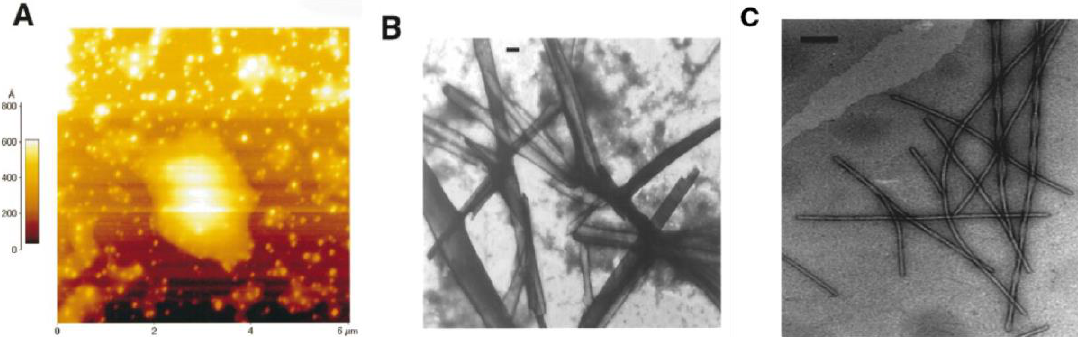
Figure 2. Atomic force (AFM) and electron microscope examination of aggregates of short sequences of hIAPP in its core mutation region. ( A ) AFM image24 (6 μm × 6 μm) of aged hIAPP 23–27 (GAIL) in solution (10 mM). The vertical bar on the left-hand side of the figure indicates the heights of the measured objects. ( B ) Electron micrograph of insoluble aggregates of hIAPP 23–27 (FGAIL) formed in an aged peptide solution. The apparent peptide concentration was 5.2 mg/mL in phosphate buffer (pH 7.4) with an incubation time of three days. The scale bar represents 200 nm. ( C ) Electron micrograph of insoluble aggregates of hIAPP 22–27 (NFGAIL) formed in an aged peptide solution. The apparent peptide concentration was 6.4 mg/mL in phosphate buffer (pH 7.4) with an incubation time of three days. The scale bar represents 200 nm. Adapted from Tenidis et al. [30]. Copyright (2000) with permission from Elsevier.